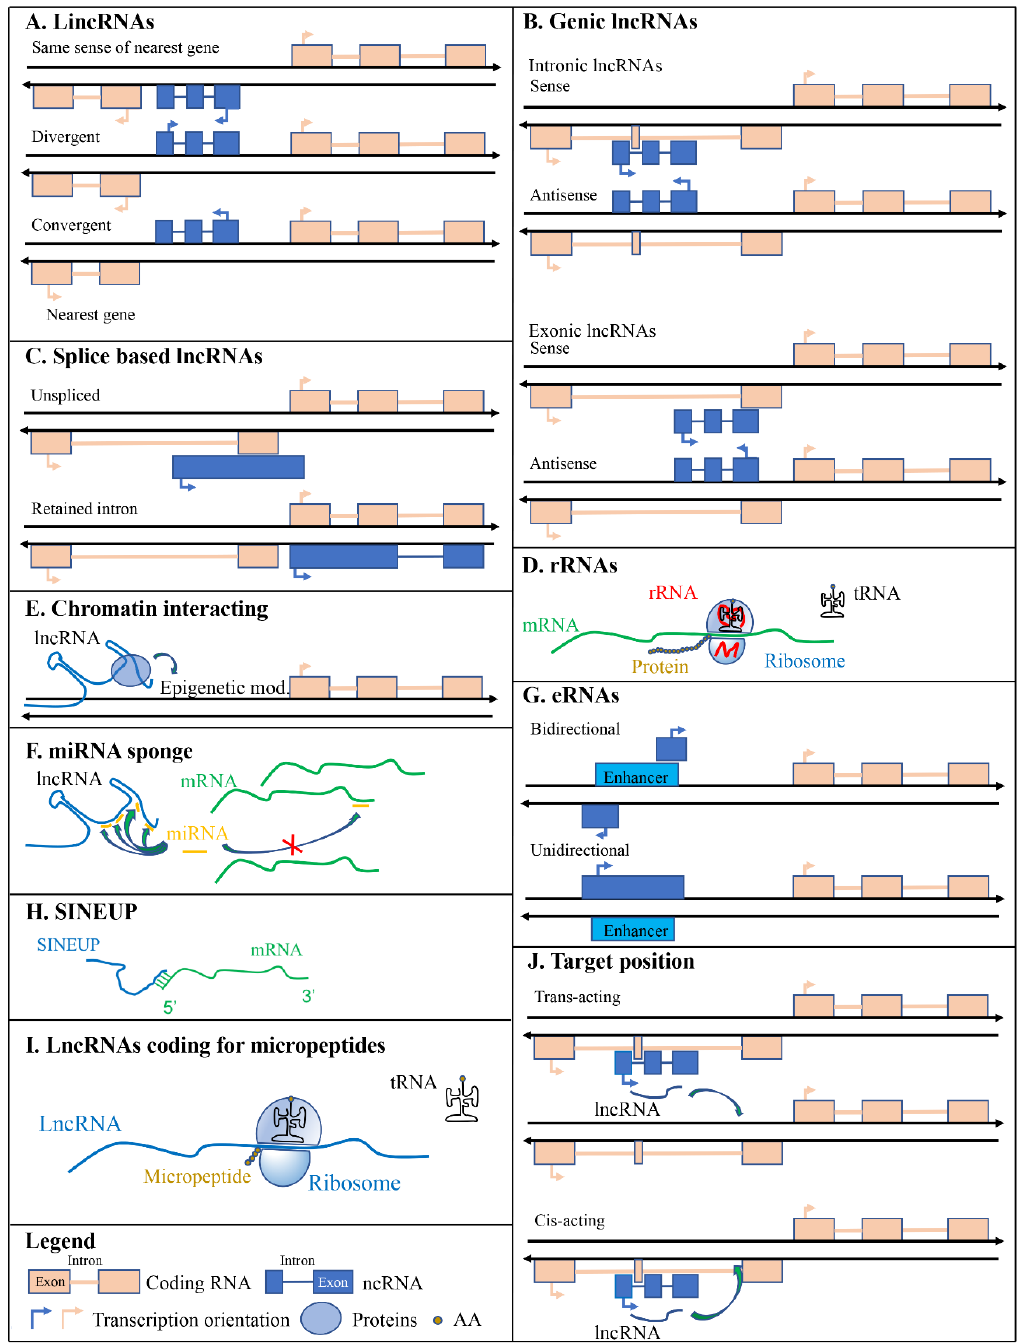
Figure 2. Scheme of different types of long non-coding RNAs (lncRNAs). ( A ) licRNAs are localized between coding genes and do not overlap any of them. ( B ) Genic lncRNAs are overlapped to coding sequences. ( C ) Splice variants. ( D ) Ribosomal RNAs are components of ribosomes. ( E ) Chromatin interacting lncRNAs allow chromatin modifications permitting the correct localization of modifying enzymes. ( F ) miRNA sponging lncRNAs reduce the availability of miRNAs to modulate the expression of their mRNA target. ( G ) Enhancer lncRNAs are transcribed from DNA regions with enhancing functions. ( H ) SINEUPs are lncRNAs that associating to mRNAs are able to enhance their translation. ( I ) lncRNAs can also code for micropeptides. ( J ) lncRNAs are distinguished according to the position of their targets. Green arrows indicate protein ( E ), miRNA ( F ), or lncRNA ( J ) targets. AA is for amino acids.